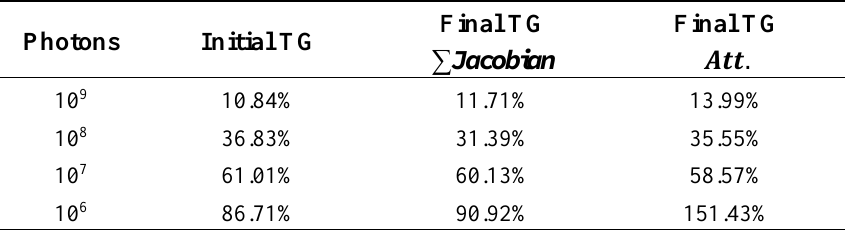
Table 5. Errors in the forward model central nodes before and after ∑ 𝐽𝑎𝑐𝑜𝑏𝑖𝑎𝑛 mesh